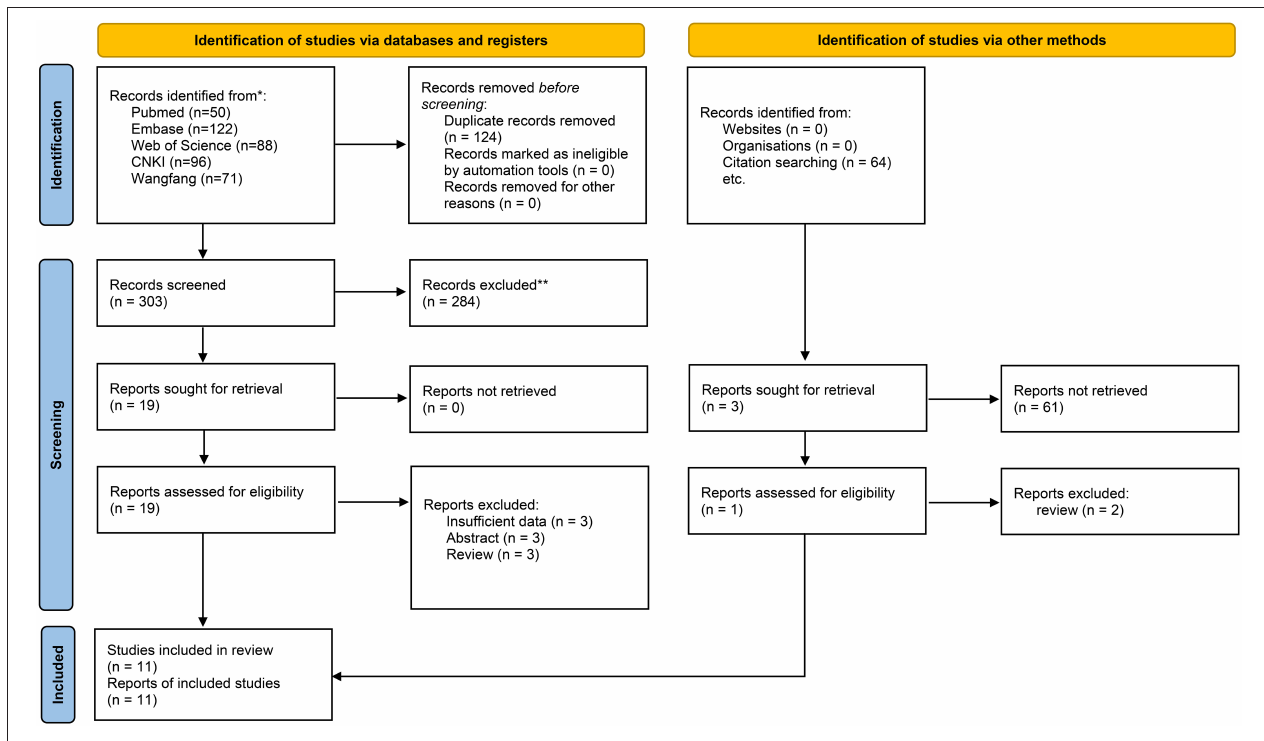
FIGURE 1 | Flow diagram of study